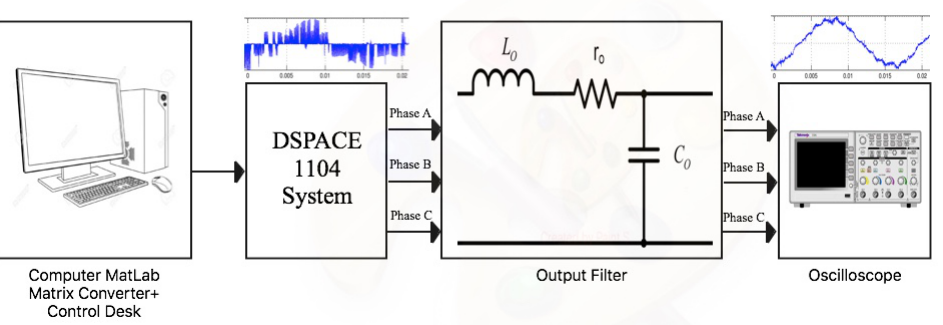
Figure 15. Schematic of the experimental model.